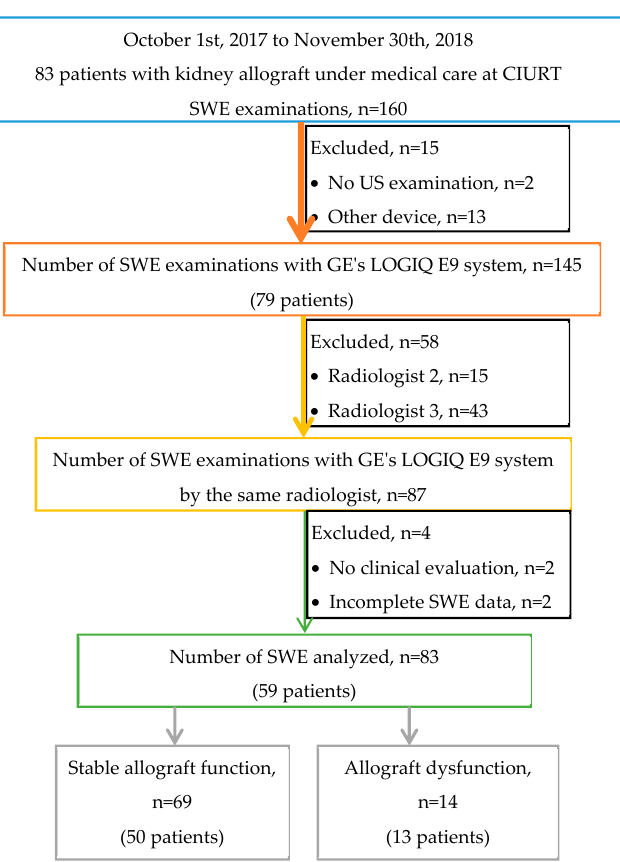
Figure 3. Diagram illustrating the flow of the study, from the eligible population to the inclusion of SWE examinations in the analysis. The characterization of the kidney allograft function was done according to clinical evaluation and laboratory measurements. Nineteen patients with stable allograft have two SWE evaluations; one patient with allograft dysfunction had two examinations. Table 1. Main characteristics of the investigated cohort.